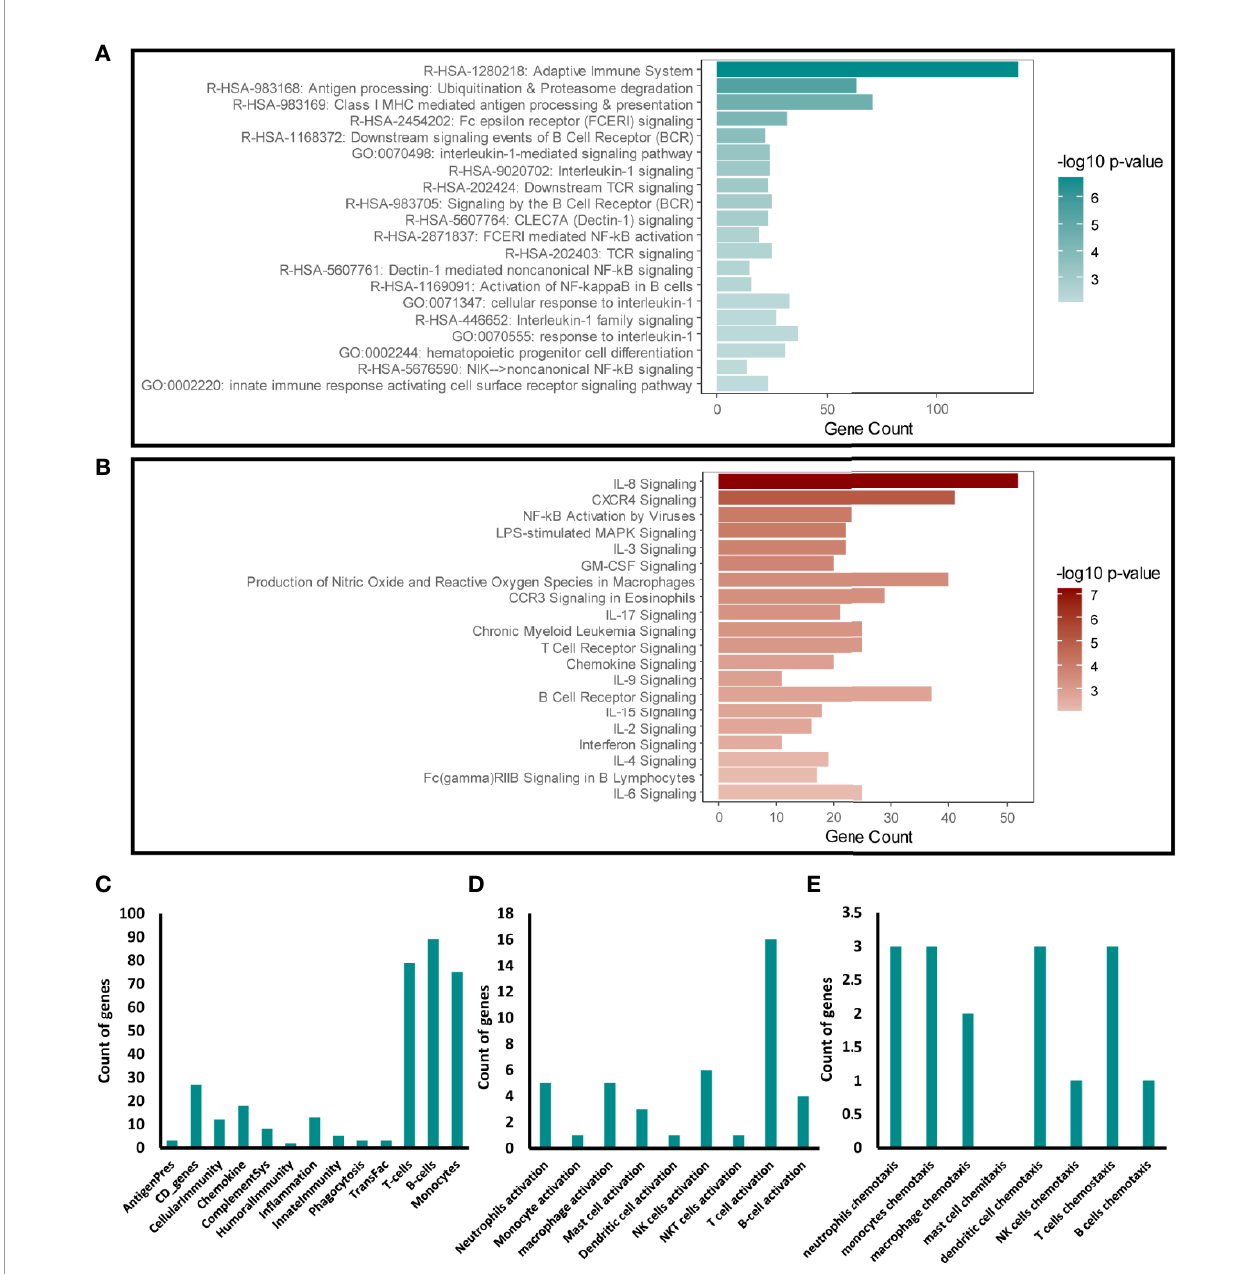
FIGURE 2 | Immunomodulatory effect of Snail-p53 binding inhibition. Enriched representation of the top 20 immune response pathways and functional clusters identi fi ed in analysis conducted using (A) Metascape and (B) IPA. The count of intersecting genes from the GN25 treated cells with the (C) Immunome set (D) , immune cells activation gene ontology sets, and (E) immune cells chemotaxis gene ontology